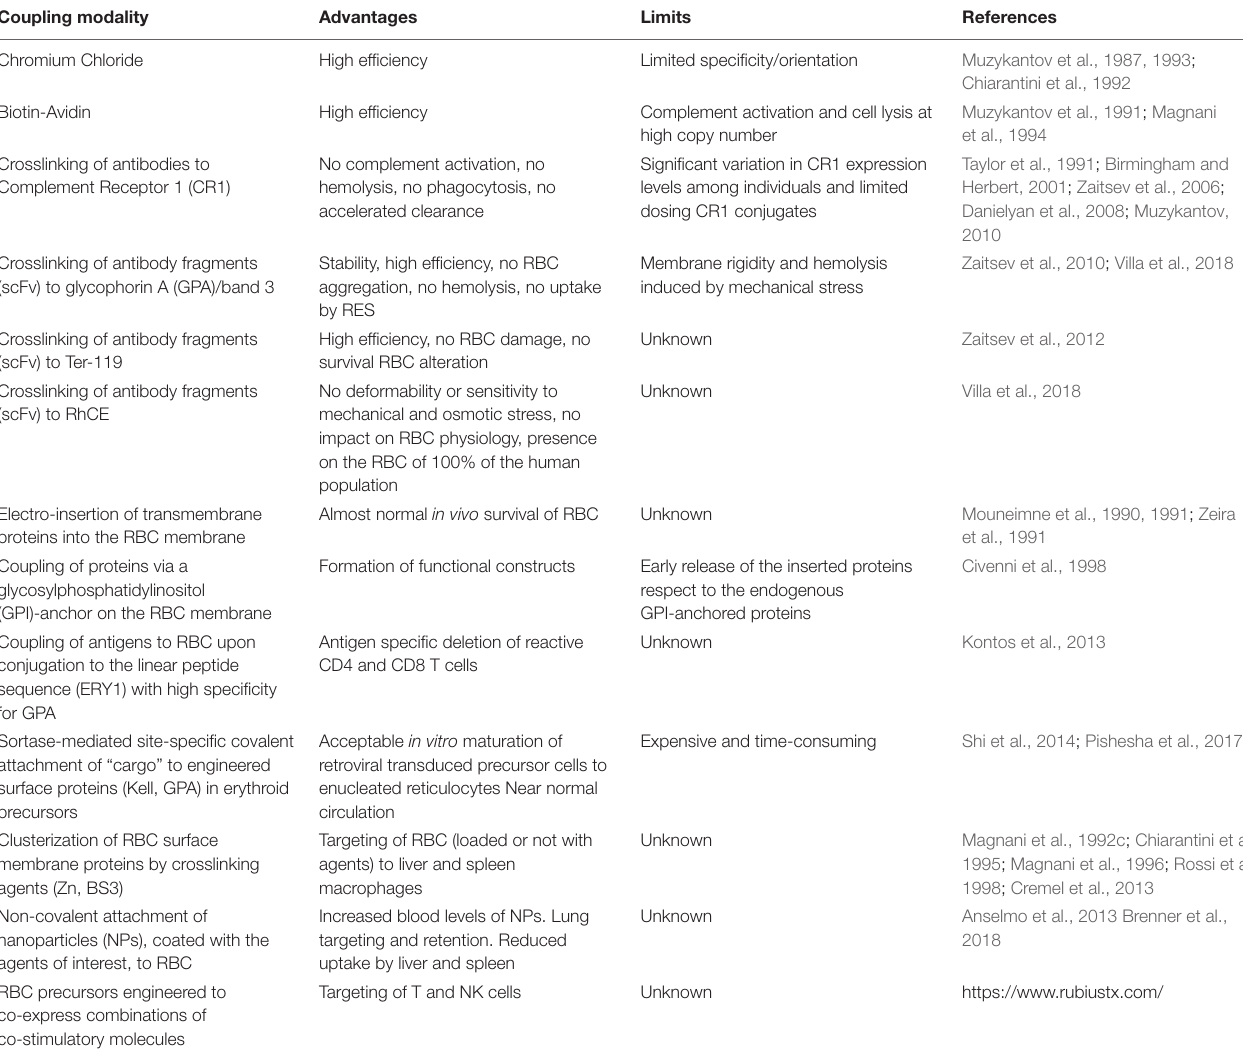
TABLE 1 | Coupling modalities for the binding of molecules of interest to the RBC